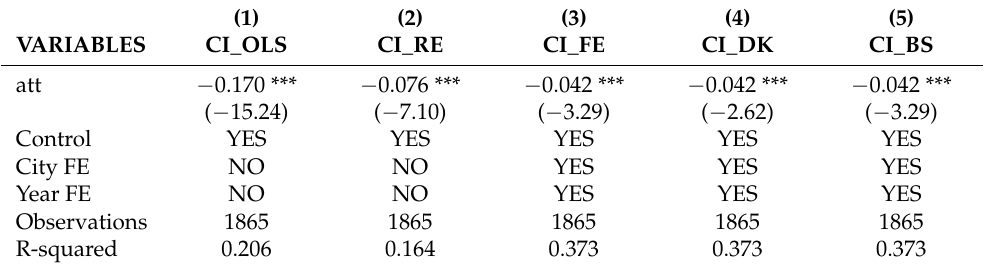
Table 3. Estimation results of the benchmark regression for CI.